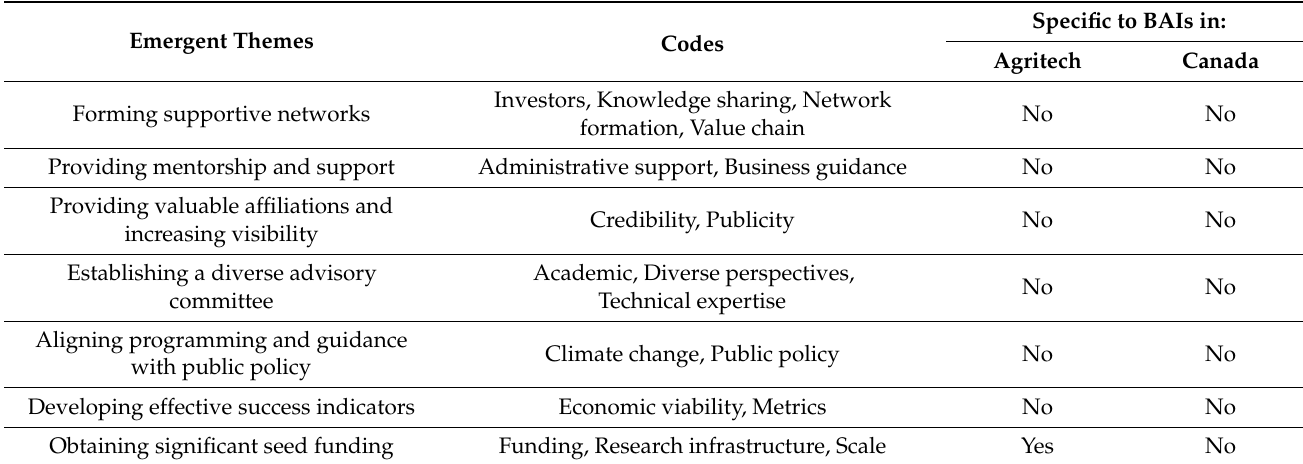
Table 3. Success factors related to increasing agritech incubator and accelerator